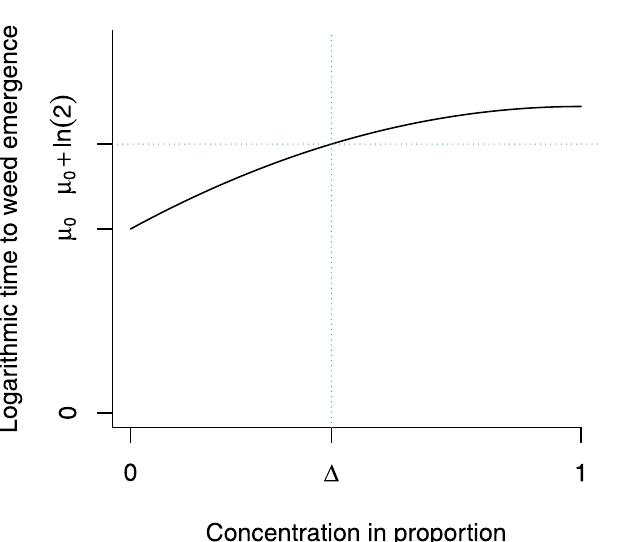
Fig 3. The relation between Δ and μ Δ . The y-axis represents the logarithmic time to weed emergence, and the x-axis represents the ethanol concentration. The value of Δ corresponds to the concentration such that the expected time to weed emergence increases by ln(2). In other words, the median time doubles at the concentration of Δ when compared to the zero (control) concentration.